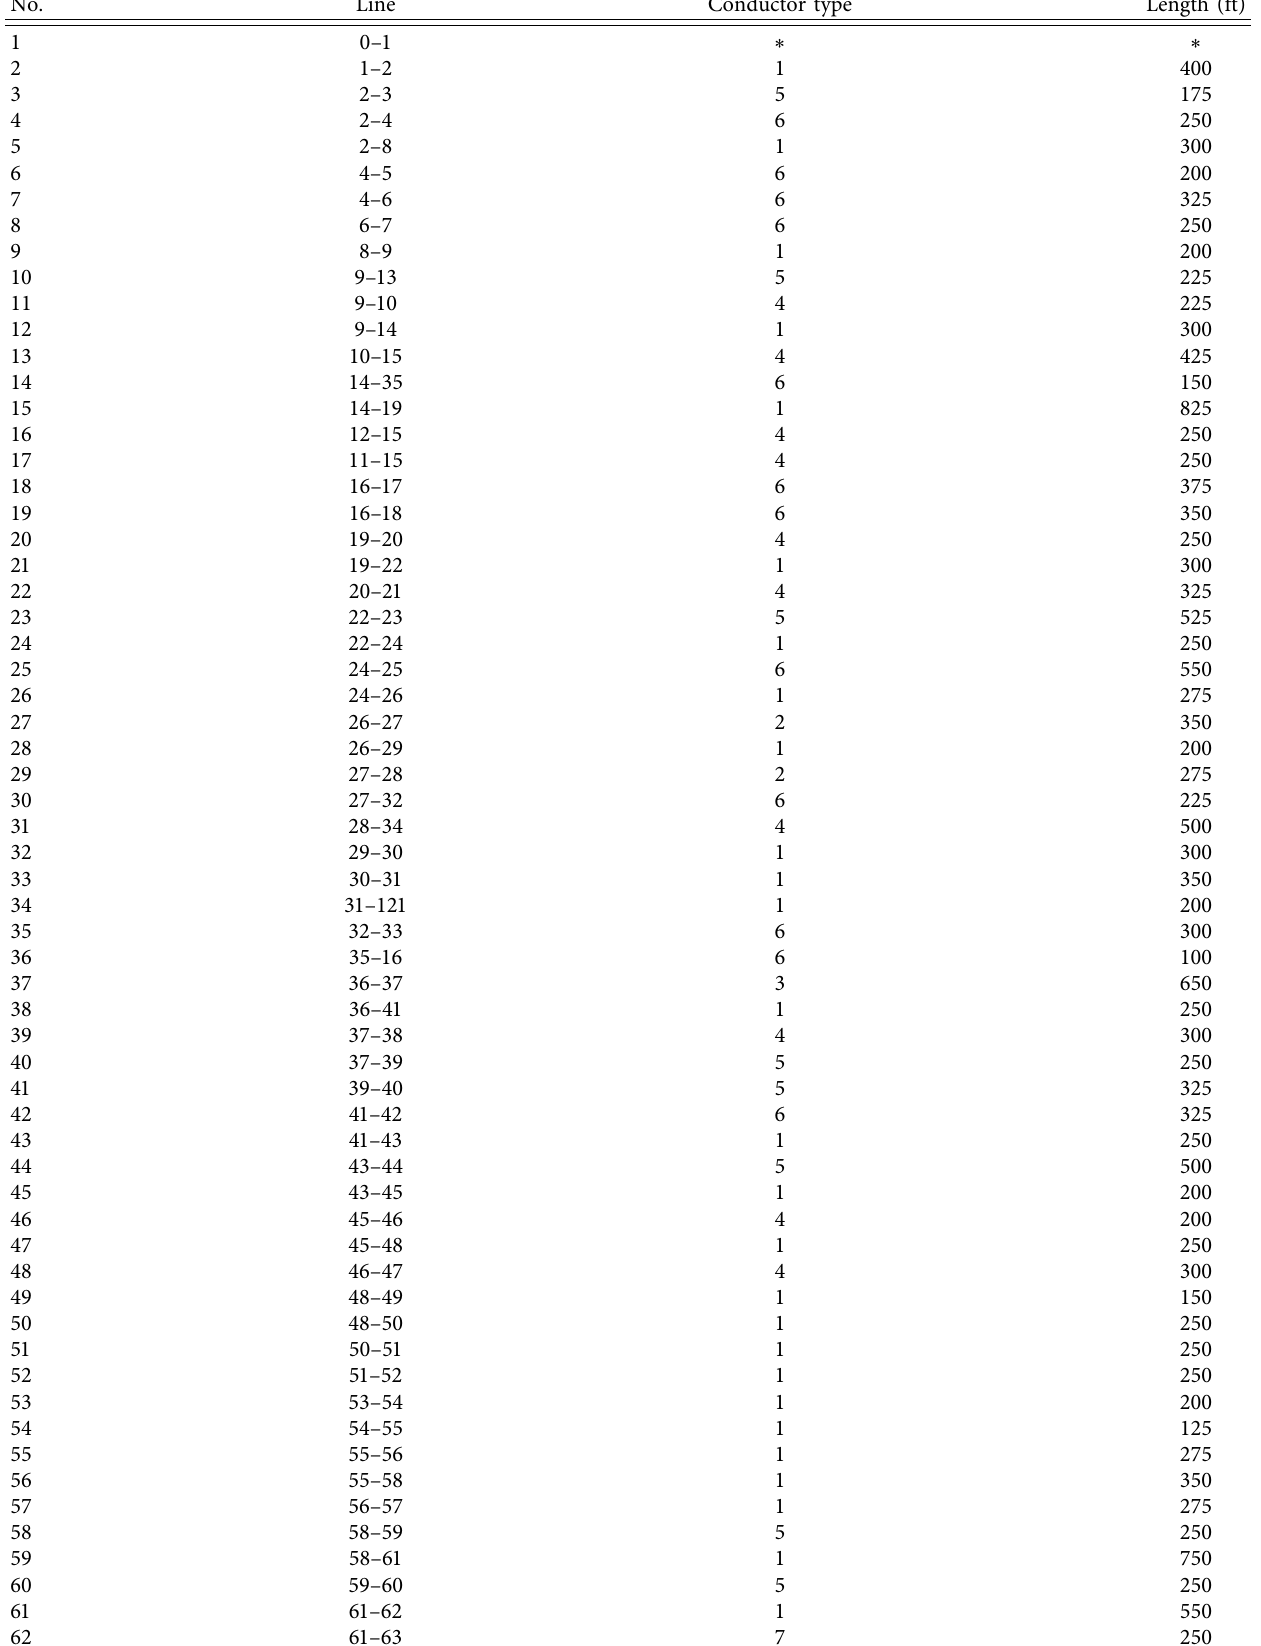
Table 8: Type and length of conductor lines of 123-bus